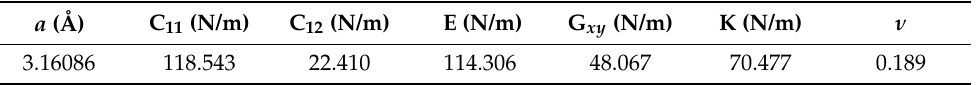
Table 3. Calculated lattice parameters, elastic components, and elastic modulus of CF 2 Si